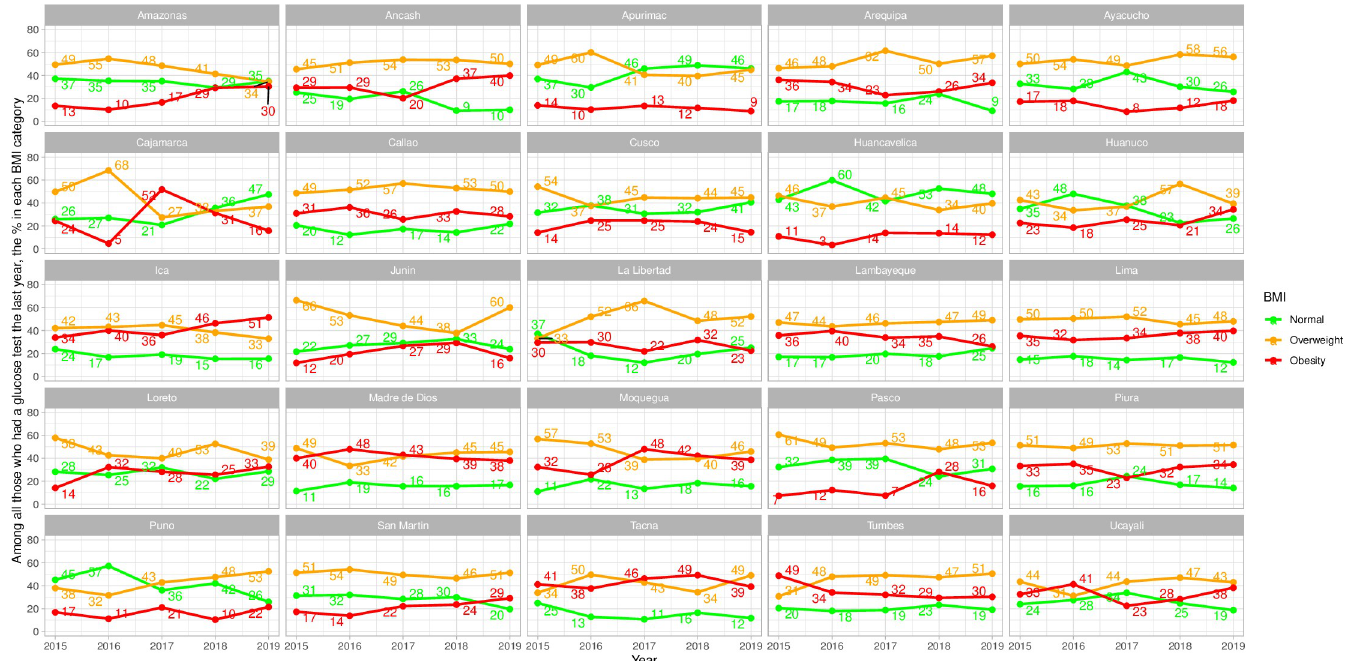
Fig 3. Sub-national time trends of glucose test by body mass index categories in men.